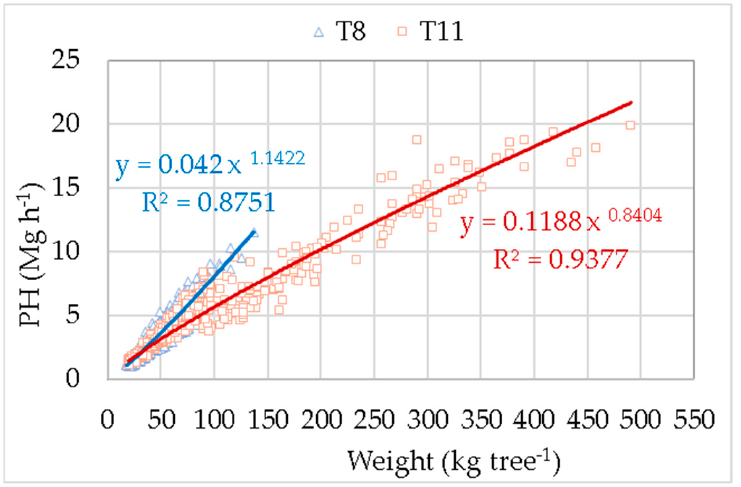
Figure 8. Work productivity ( PH ) estimate models calculated in relation to the weight of the tree for plantations T8 and T11.